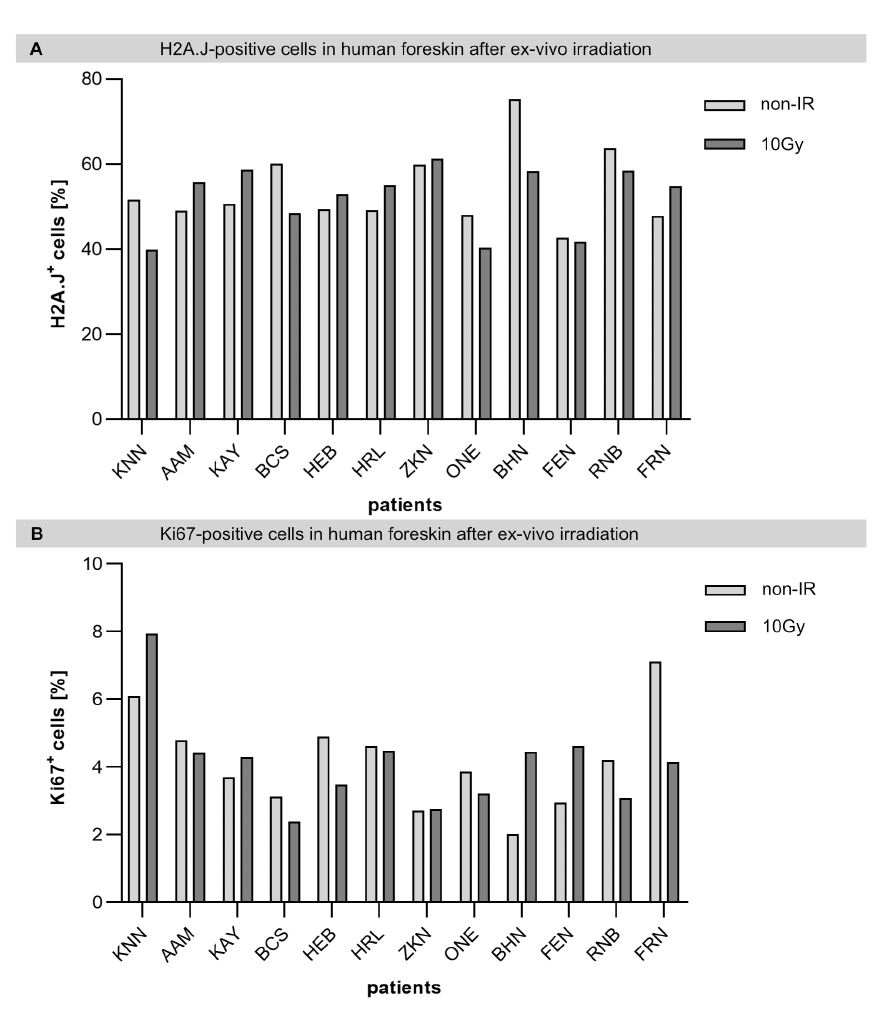
Figure 2. Patient-to-patient variability of H2A.J and Ki67 expression in foreskin explants before and after ex vivo IR exposure. Graphic presentation of the quantification of H2A.J+ ( A ) and Ki67+ keratinocytes ( B ) in the epidermis of foreskin explants before and after IR exposure (10Gy; 24 h post-IR) for the individual donors (listed with the initials of their names) ( n = 12).